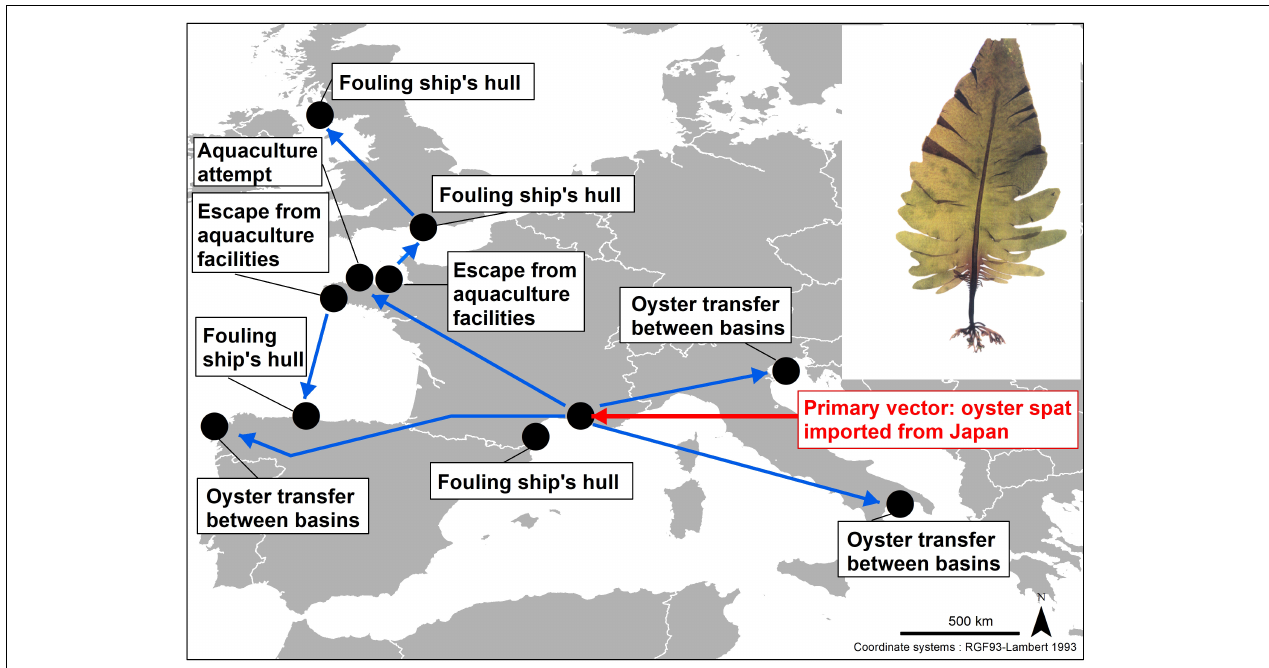
FIGURE 4 | Primary (red arrow) and secondary (blue arrows) vectors of spread of Undaria pinnatifida (“brown alga,” Stramenopiles) in the Mediterranean and western Europe. Only some of the sites where U. pinnatifida occurs, along the western coasts of Europe, have been represented.